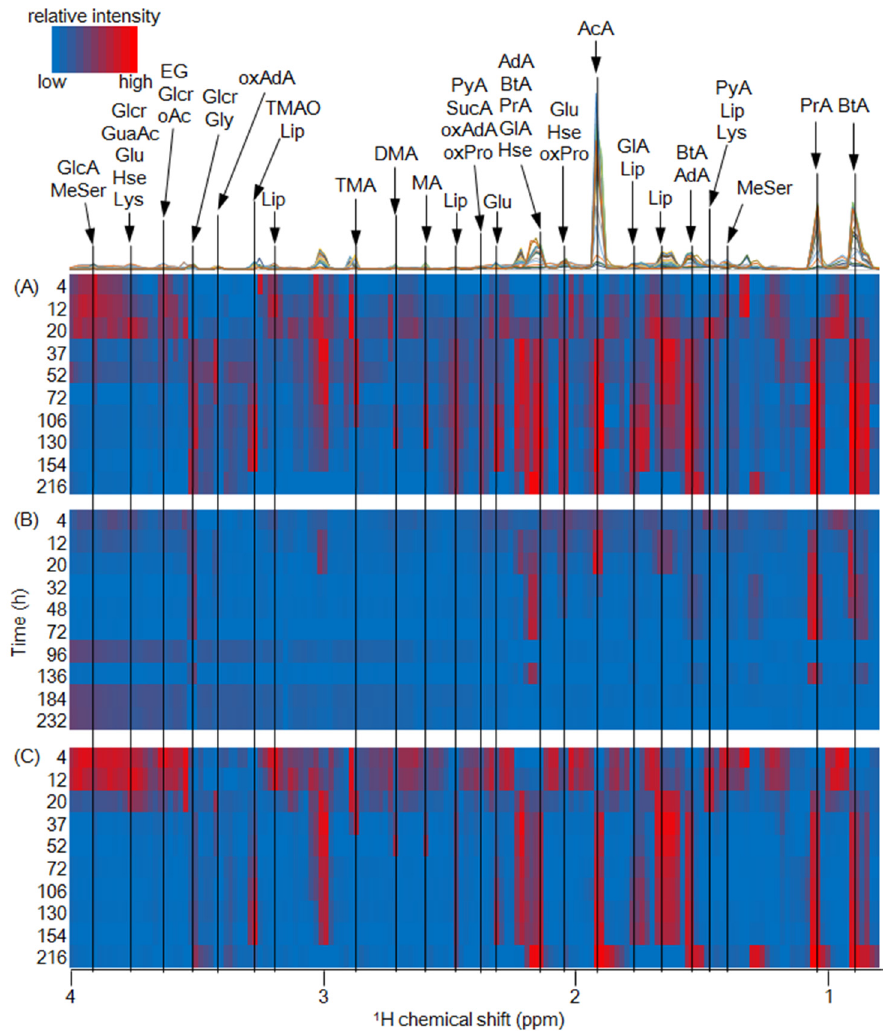
Figure 3. Visualization of metabolic dynamics of fish meat ( A ); fins ( B ); and bony parts ( C ) of left-eyed flounder in anaerobic microfloral digestion processes. Red and blue color denotes high and low intensities of the NMR signals, respectively.